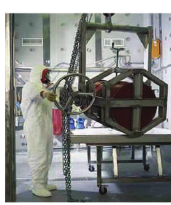
Fig. 10. The Alceste shielded cell.